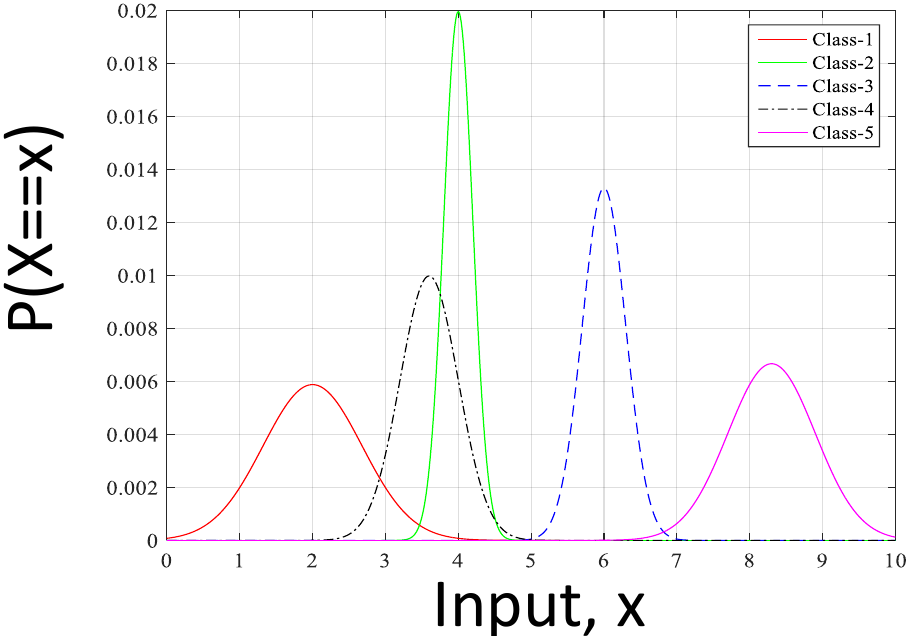
Figure 3. Probability density functions (PDF) for each class. Each class corresponds to a unique sequence or finger-gesture.